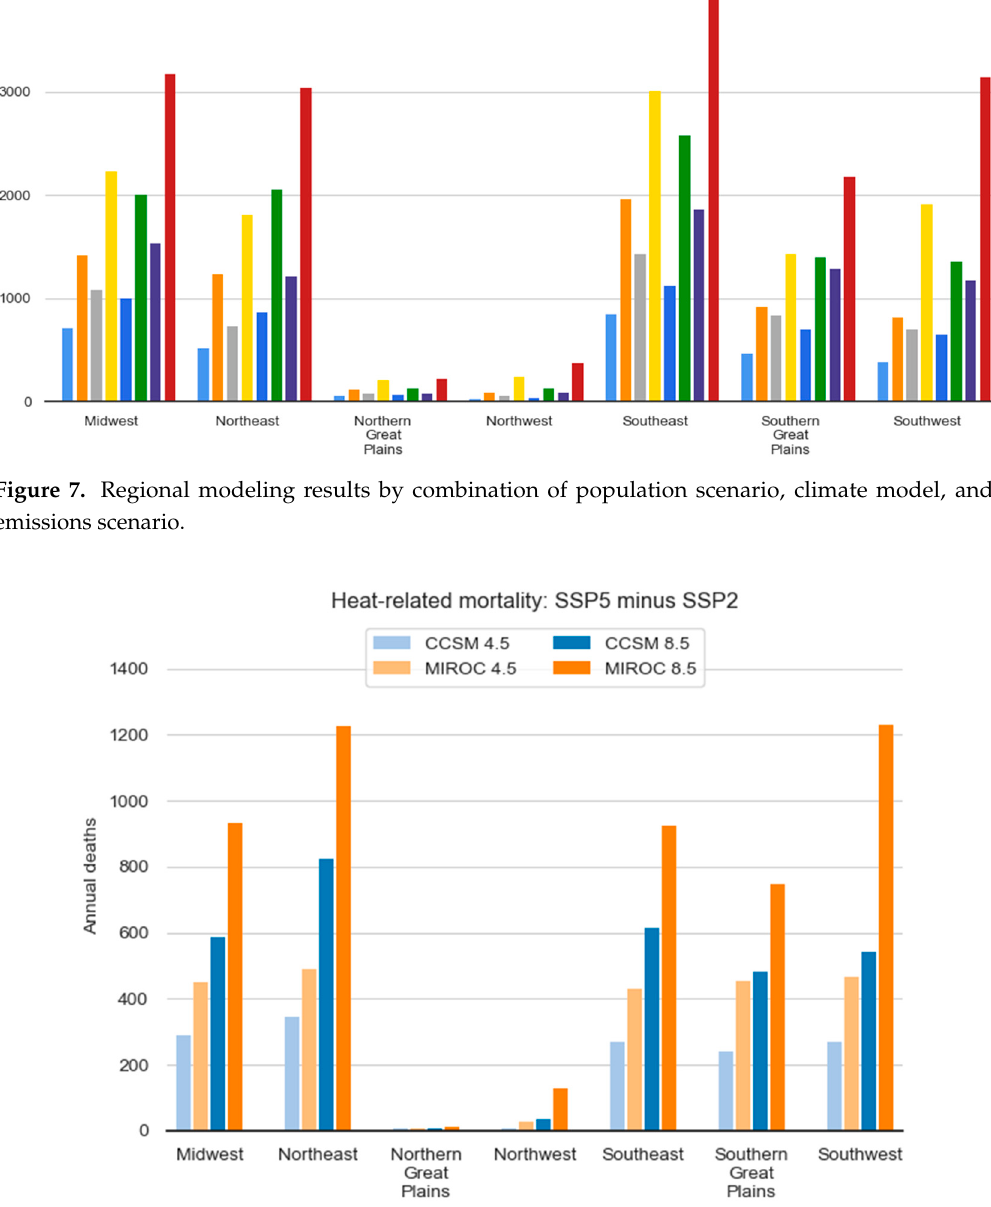
Figure 8. Population projections had the largest influence overall in the Northeast and Southwest.